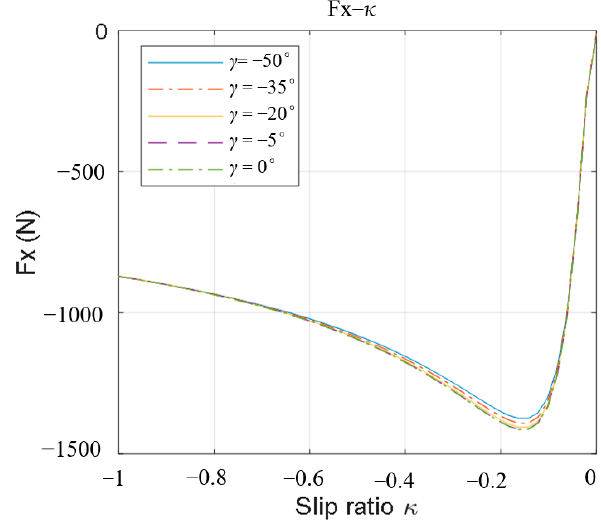
Figure 4. Longitudinal characteristics of a tire.